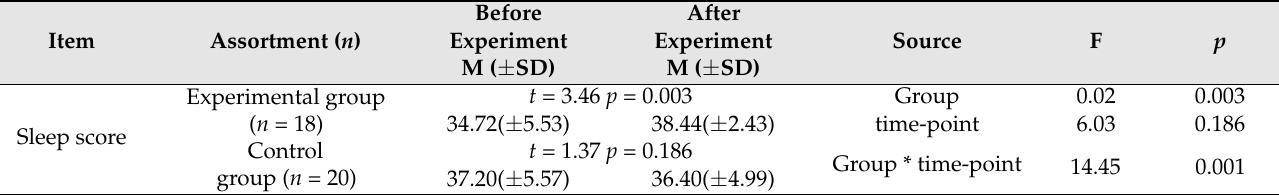
Table 3. Inter-group Difference Test for Sleep Score ( n = 38).